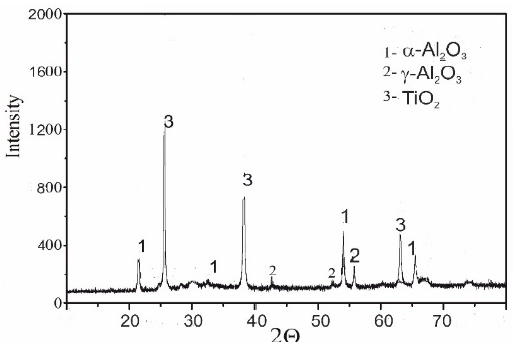
Figure 6. X-ray diffraction pattern of the HVOF sprayed Al 2 O 3 -15 wt.% TiO 2 coating on the Al-Si cast alloy.